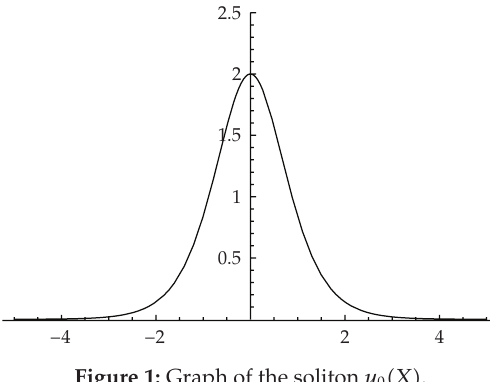
Figure 1: Graph of the soliton u 0 (cid:3) X (cid:4)